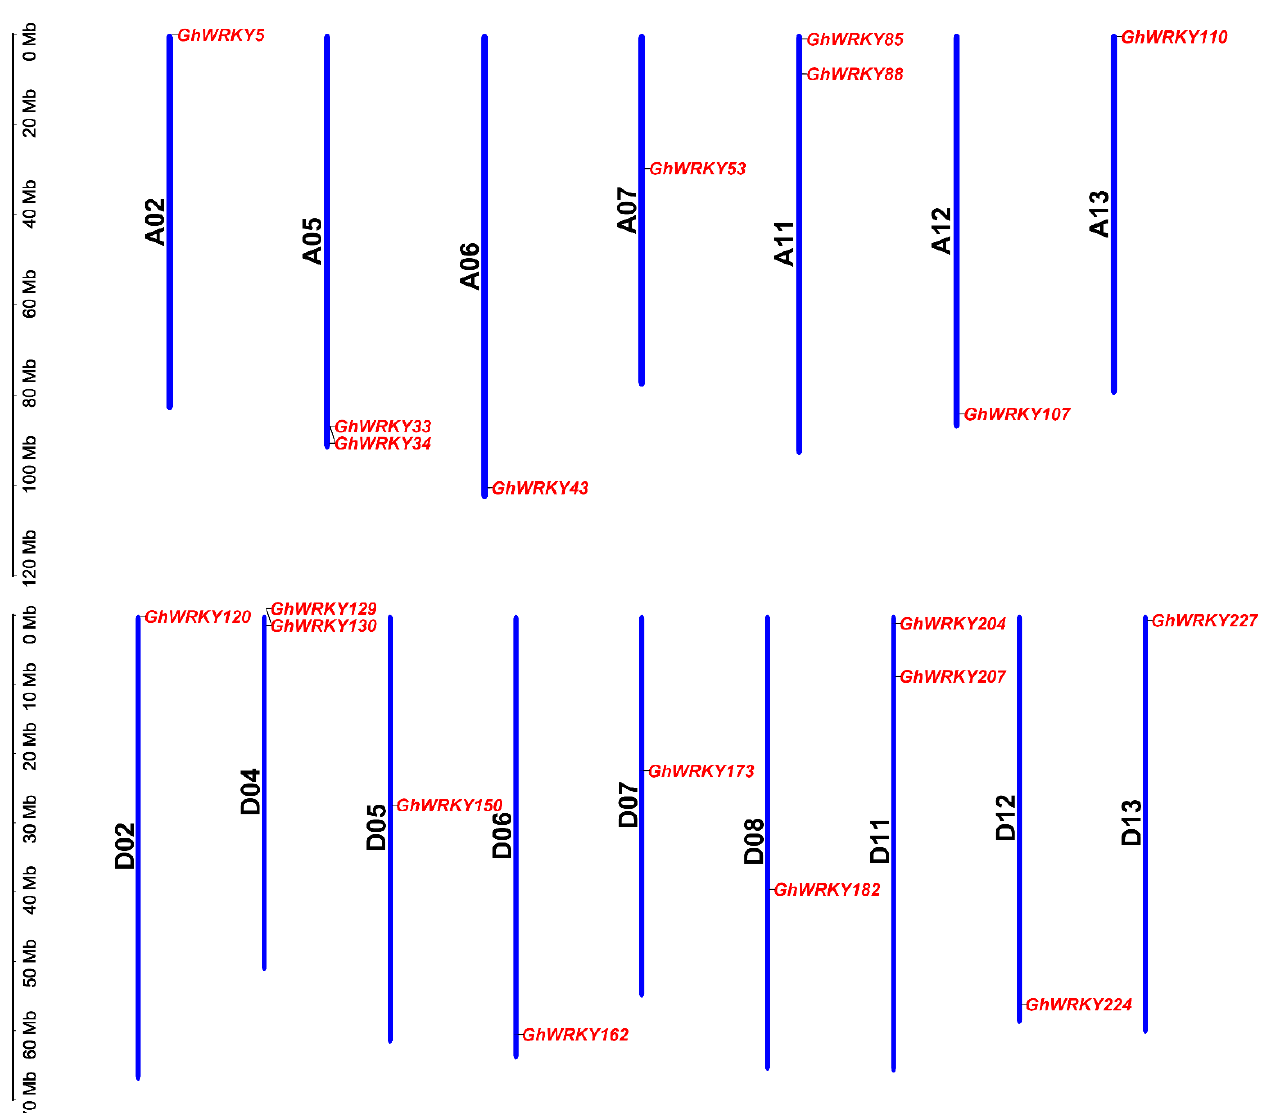
Figure 1. Chromosomal distribution of putative group III WRKY genes in G. hirsutum L. The scale represented megabases (Mb). The chromosome IDs are indicated beside each vertical bar. The GhWRKYs are displayed on different chromosomes. Blue bars represented the length of the chromossomes in G. hirsutum L.